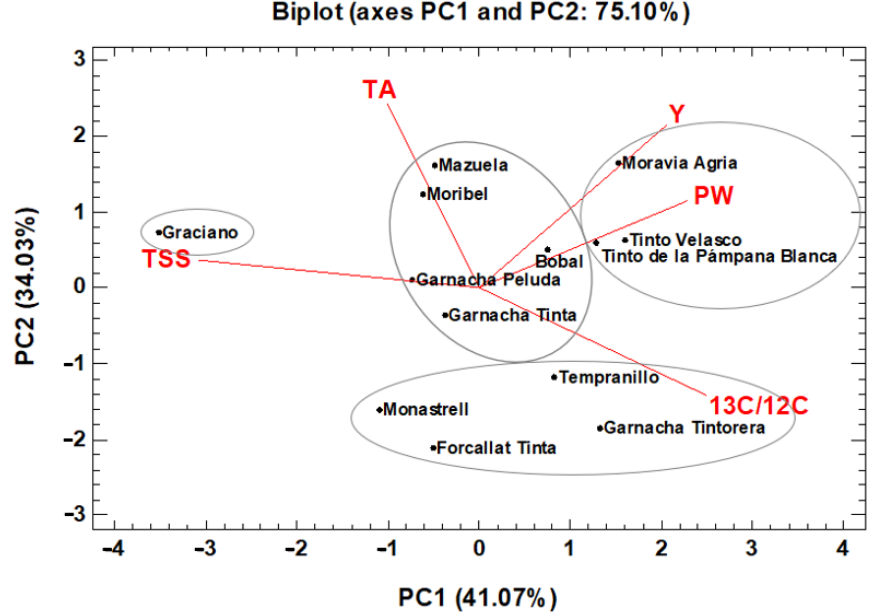
Figure 6. Principal components analysis (PCA) of agronomic traits in 13 red grapevine cultivars. Abbreviations: TSS, total soluble solids; TA, total acidity; Y, yield; PW, pruning weight; 13C/12C, must carbon isotope